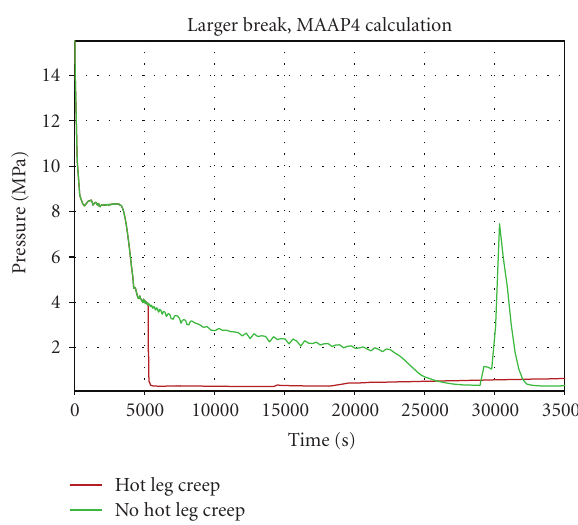
Figure 12: RCS pressure, MAAP4 calculation, Group